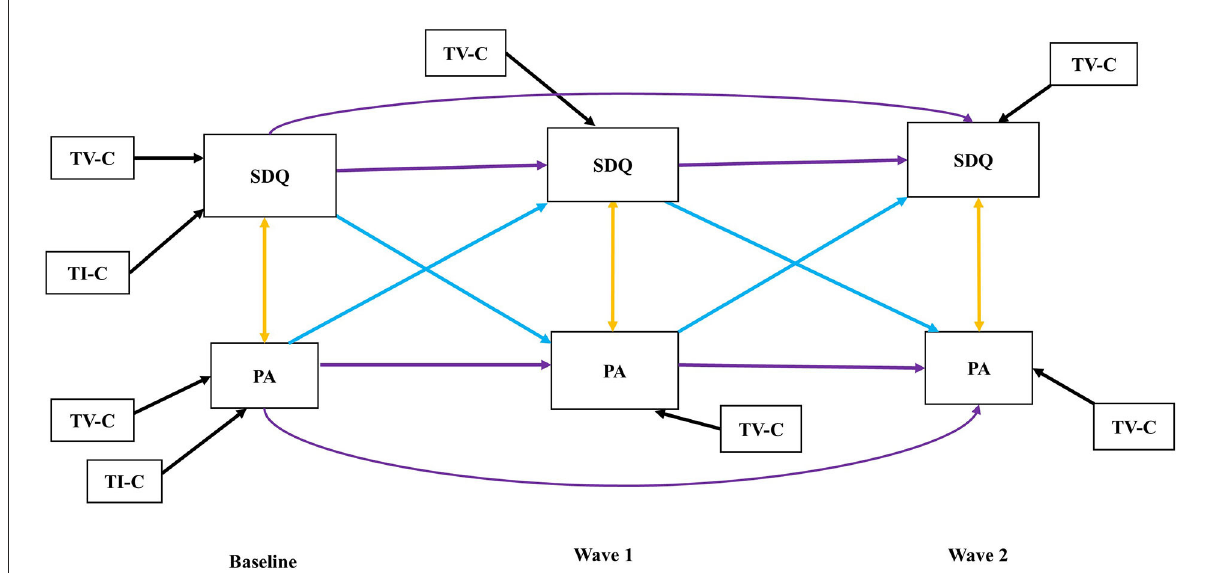
FIGURE2 Autoregressive cross-lagged model. TV-C: Time-variant covariate, TI-C: Time-invariant covariate, Purple arrows: Auto-regressive paths, Blue arrows: Cross-lagged paths, Yellow arrows: Cross-sectional paths, Black arrows: Covariate paths, SDQ: Indicating SDQ-Total for the first model as well as SDQ-H/I for the second model at Baseline, Wave 1, and Wave 2,